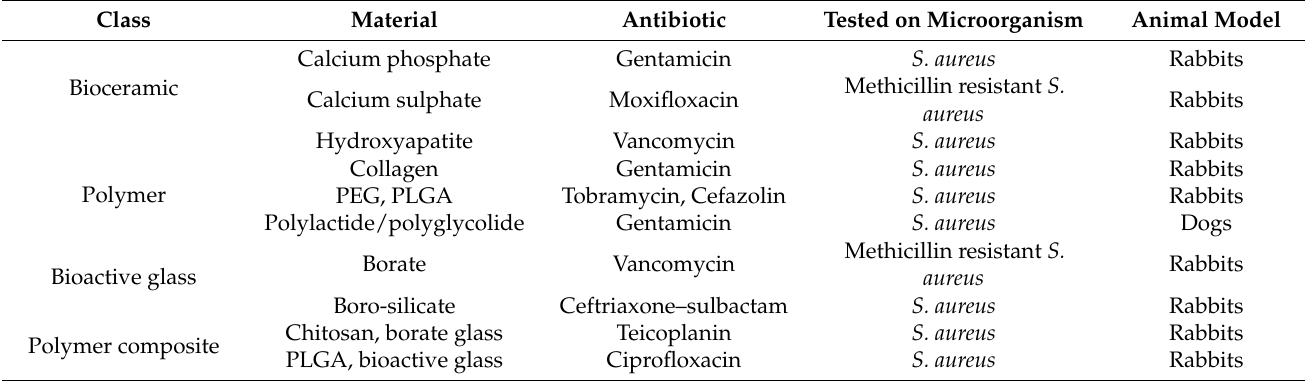
Table 4. Examples of studies of drug delivery systems for osteomyelitis